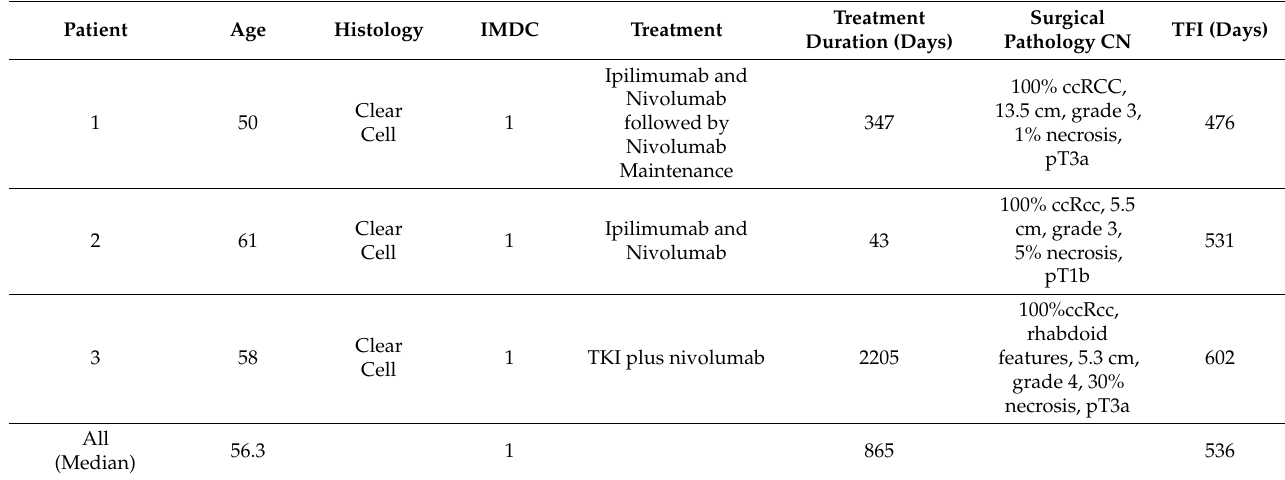
Table 1. Patient